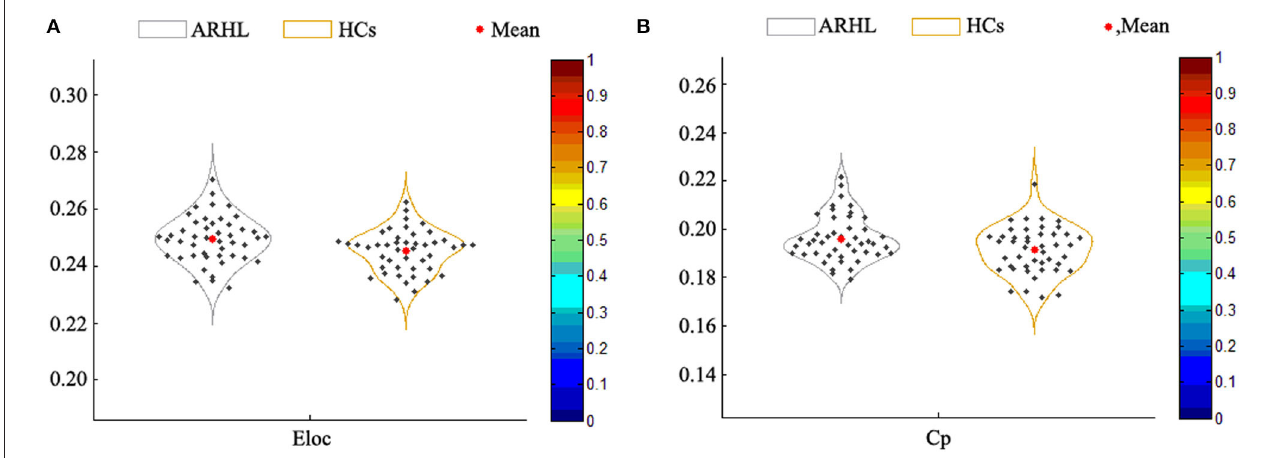
FIGURE 4 | (A) The local efficiency (E loc ) of the patient group was higher than the healthy controls ( p = 0.013). (B) The clustering coefficient (C p ) of the patient group was higher than the control group ( p =